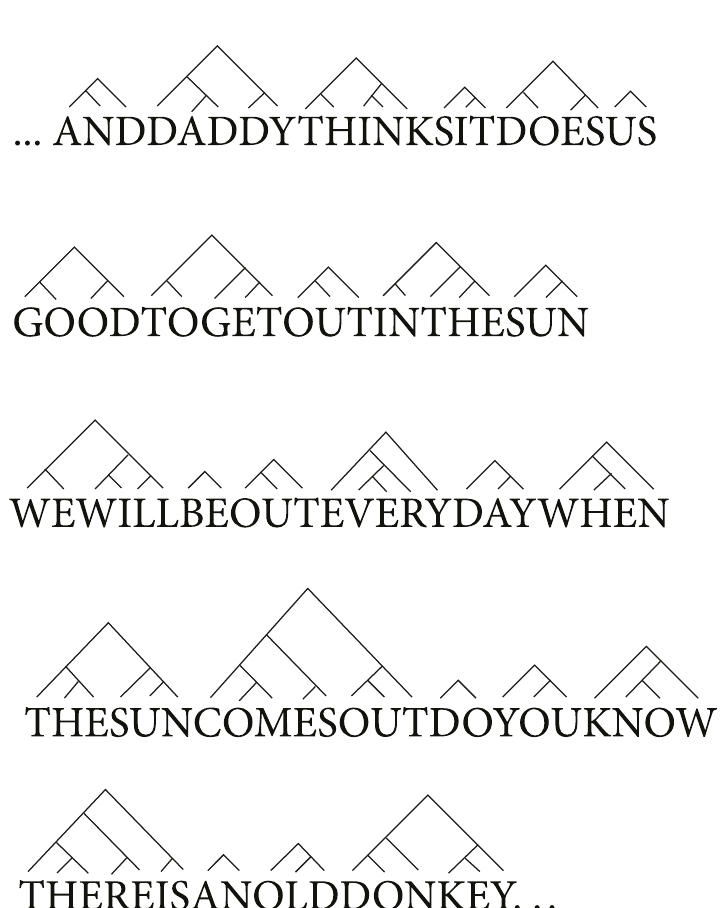
Figure 14: Part of a parsing created by the MK10 Computer Model from a 10,000-letter sample of English (book 8A of the Ladybird Reading Series) with all spaces and punctuation removed. The program derived this parsing from the sample alone, without any prior dictionary or other knowledge of the structure of English. Reproduced from Figure 7.3 in [98], with permission.